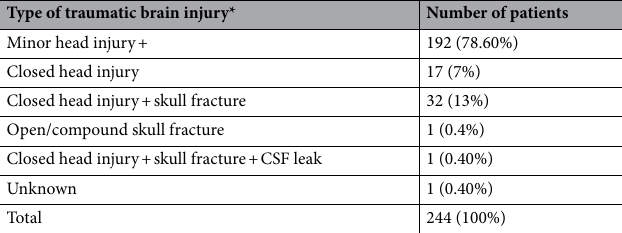
102 workers (41.8%) with a peripheral vestibular disorder (excluding positional vertigo) sustained a mTBI without LOC. Of workers with a LOC, the majority had a loss < 5 min duration (n = 67, 41.4%). Figure 2 docu- ments LOC in this head injury series. The most common occupations with a peripheral vestibular disorder came from the construction industry (46 patients) and transportation services (38 patients). See Appendix, Supplementary Tables 1, 2 and Figs. 1, 2 for information on the mechanism and severity of head injury and sex predilection in patients outside of a peripheral vestibular disorder. On subgroup analysis, there was no significant difference in mean age and mechanism of injury among dif- ferent groups with peripheral vestibular disorders (Tables 1, 3). Males predominated in all subgroups. Workers with RV or drop attacks were more frequently female. In those with an uncompensated fixed peripheral vestibular loss, LOC was significantly greater than those with RV (P = 0.007) (see Table 4). The severity of injury on clinical exam was not significantly different between subgroups (see Table 5).